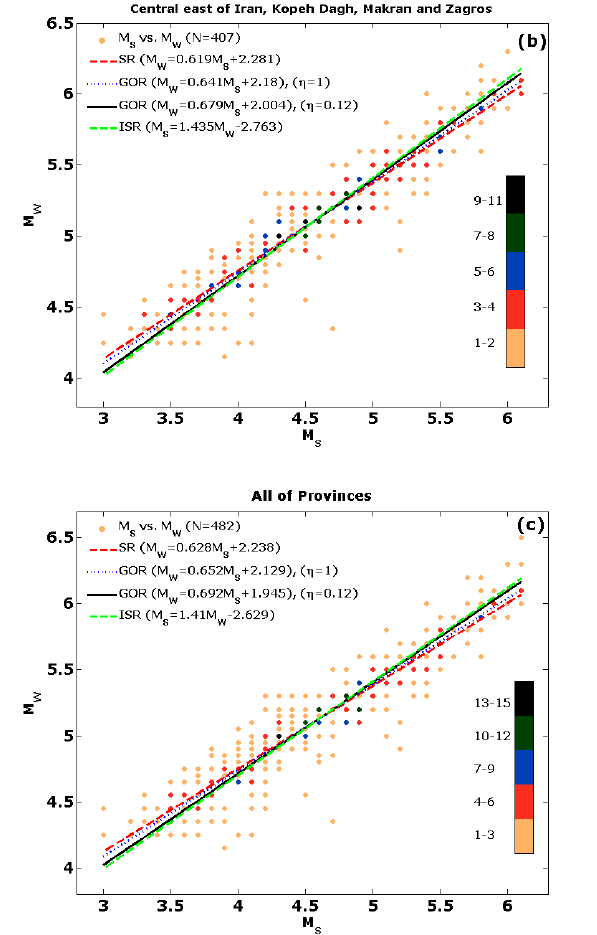
Table 3. As Table 1 for the m